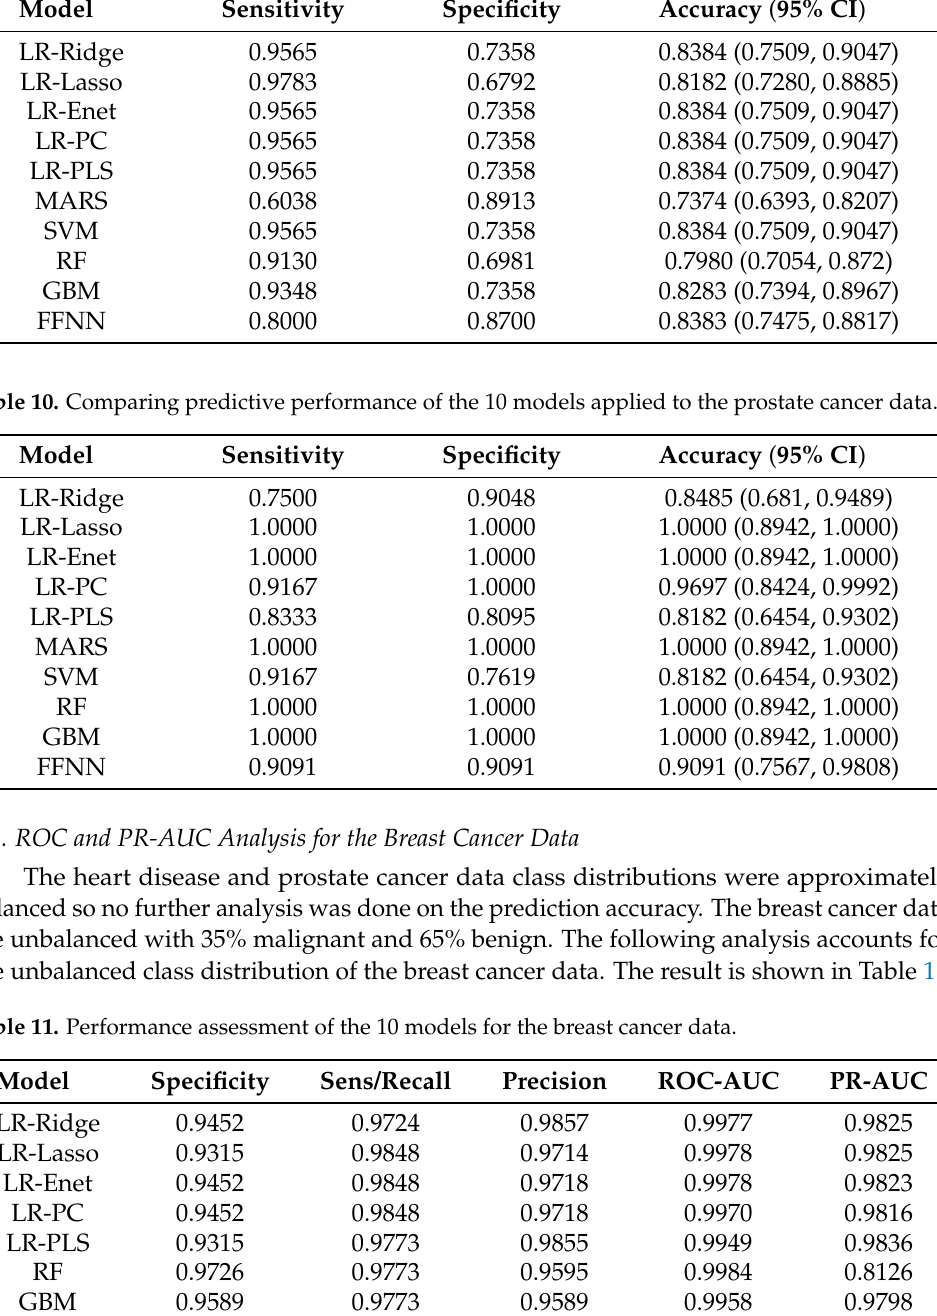
From Table 10, the linear models: LR-lasso, LR-Enet and nonlinear ensemble models: RF and GBM gave the best prediction accuracy of 1.00 for the prostate cancer data. Based on their importance plot, the top risk factors of prostate cancer severity are percent of